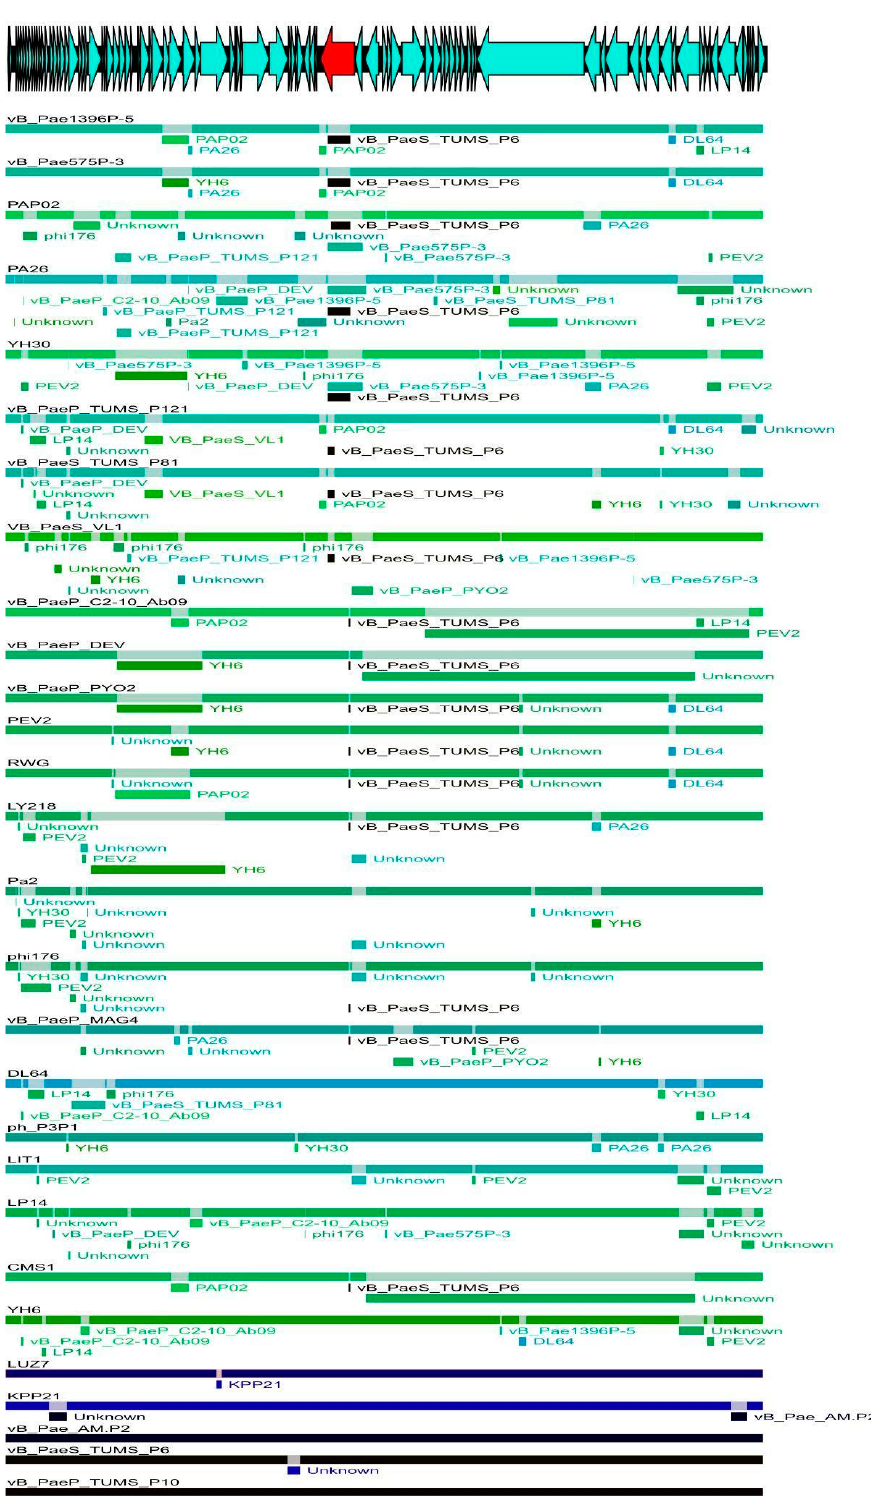
Figure 1. The map of recombination events within the genomes of Litunavirus and Luzseptimavirus bacteriophages. Phage genomes are depicted as coloured lines: light blue and green for Litunavirus ; dark blue and black for Luzseptimavirus . The recombinant fragments of the genomes are marked by rectangles in the colours corresponding to the putative source phage genomes. The schematic genome map of the studied phages is present at the top of the figure, and the variable region is marked with a red arrow.